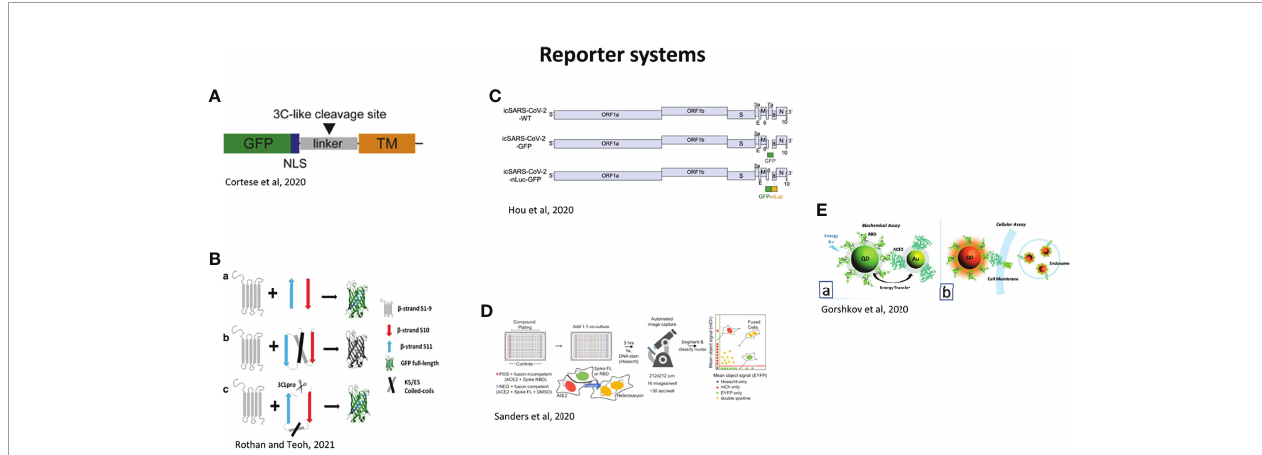
FIGURE 10 | Reporter systems for the study of SARS-CoV-2. (A) GFP-NLS-tagged SARS-CoV-2 fl uorescent reporter. NLS, nuclear localization sequence; GFP, green fl uorescent protein; TM, transmembrane region of Sec61b. Black arrowhead: SARS-CoV-2 3C-like protease cleavage site. SARS-CoV-2-infected cells transiently expressing the GFP-NLS-tagged SARS-CoV-2 fl uorescent reporter will show nuclear translocation of the GFP-NLS reporter (Cortese et al., 2020). (B) GFP-split complementation method. (a) When GFP is split into b 1 – 9 and b 10 – 11, GFP loses its fl uorescence. b 10 – 11 in anti-parallel position binds to b 1 – 9, and green fl uorescence is restored. (b) Insertion of E5/K5 heterodimer is used to fl ip b 10 and b 11 in parallel form and prevents self-assembly of the split GFP. (c) In the presence of the SARS-CoV-2, 3CLpro cleaves between E5/K5 heterodimer and b 11, b 11 fl ips back, which enables self-assembly with b 1 – 9 and green fl uorescence is restored (Rothan and Teoh, 2021). (C) Genomes of SARS-CoV-2 recombinant viruses. GFP or GFP-fused nLuc genes were introduced into the ORF7 (replacing aas 14 – 104) of SARS-CoV-2 genome (Hou et al., 2020). (D) Heterokaryon assay. Equal parts acceptor cells (express ACE2-iRFP and FUS-mCherry) plus donor cells (express spike FL-iRFP and HNRNPA1- EYFP) are co-cultured in 384-well microtiter plate: positive control (spike RBD, red column), negative control (DMSO, blue column), test compounds (other columns). After 5 hr, cells are fi xed and nuclei are stained (Hoechst) then identi fi ed/segmented by automated confocal microscopy. Fraction cells fused is determined by percent co-positive (mCherry and EYFP) nuclei (Sanders et al., 2021). (E) Assays using nanoparticles. (a) Biochemical assay: the recombinant spike Receptor Biding Domain (RBD) is conjugated to fl uorescent quantum dots (QDs), and ACE2 receptor is conjugated to gold nanoparticles (AuNP-ACE2). In case of binding of RBD to ACE2, energy transfer from Qd-RBD to AuNP-ACE2 occurs. (b) Cellular assay using QD-RBD interaction with ACE2 (with or without GFP modi fi cation at the end of the C-terminal) on the cell membrane (Gorshkov et al.,